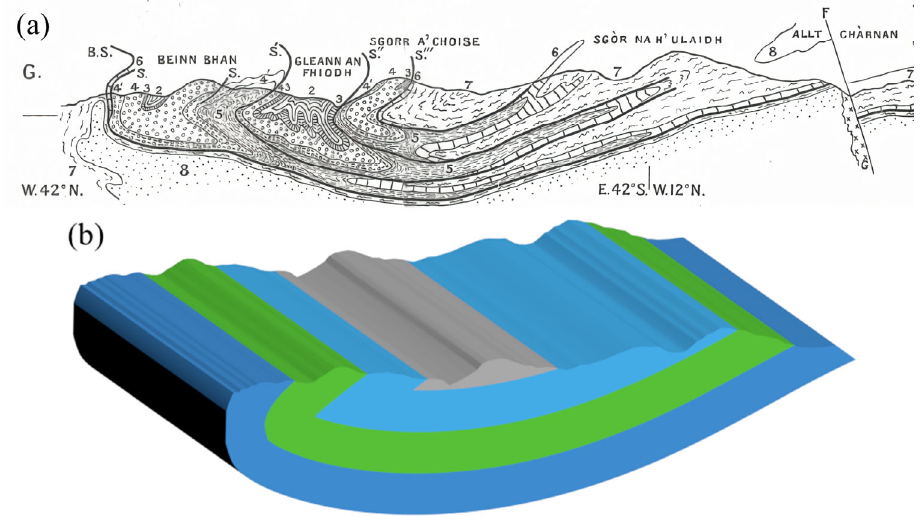
Figure 16. Section map and modeling result of recumbent fold in the Scottish Highlands: ( a ) geological section map of the recumbent fold and ( b ) symbol model of the recumbent fold. Entities with different colors represent different strata.